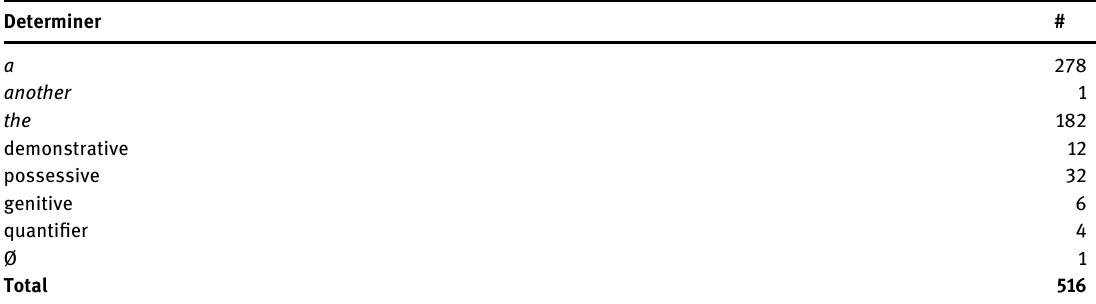
Table 7: Determiners in Mod - Num NPs